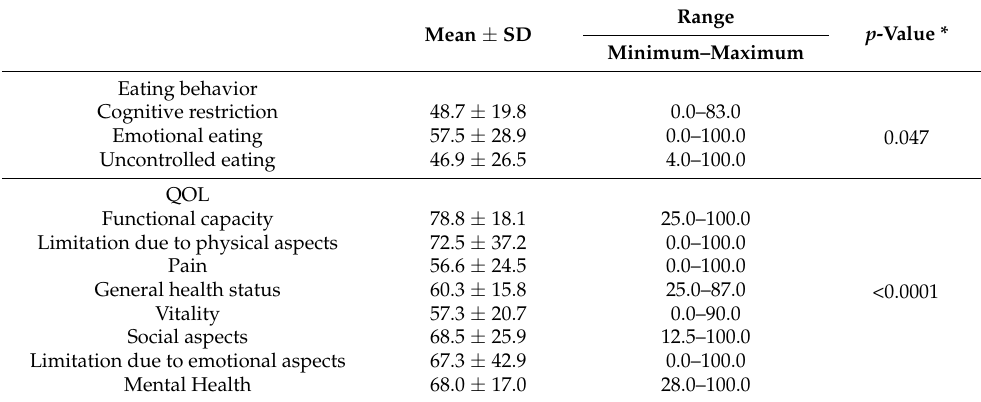
Table 1. Eating behavior and perception of quality of life in women with more than 24 months after bariatric surgery.